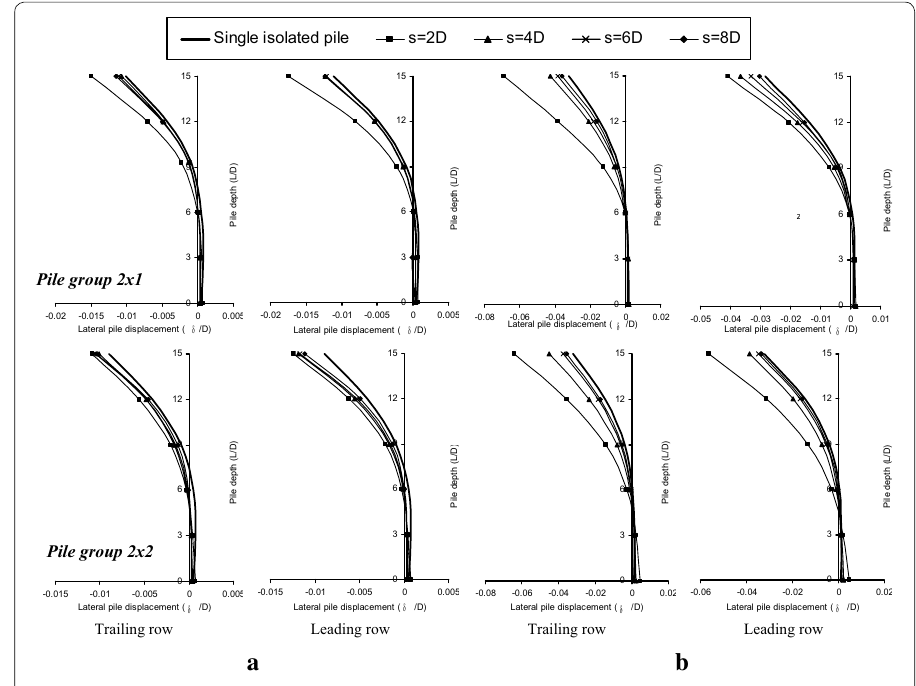
Fig. 4 Influence of pile spacing on the lateral pile displacement with depth of group piles (2 (2 2), a cohesionless soil and b cohesive ×